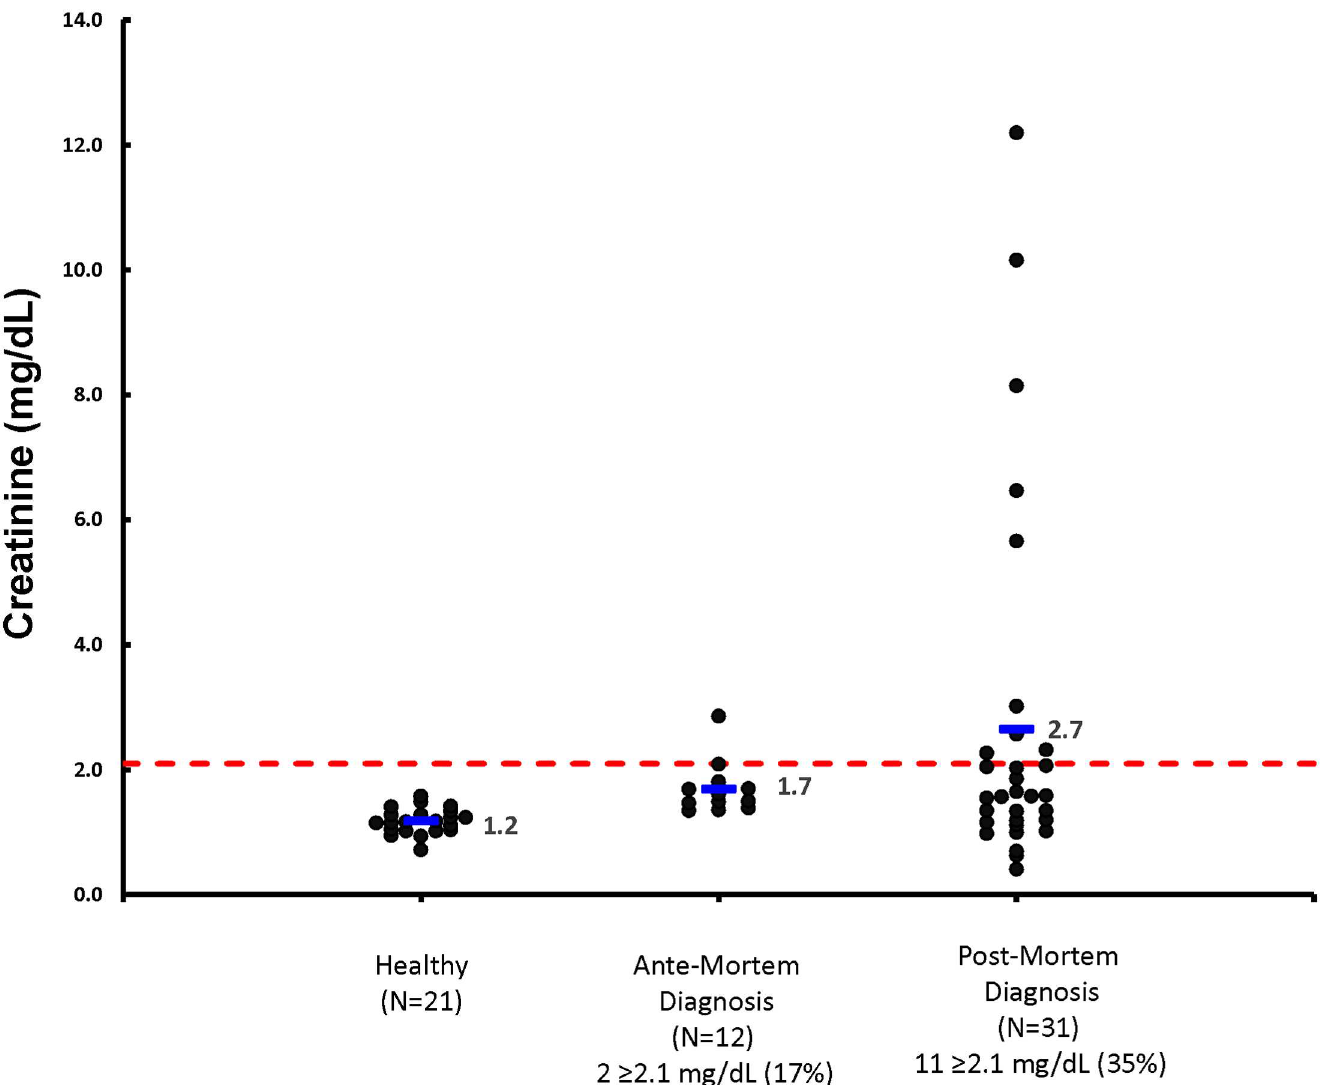
intervalfor serum Cr concentration (2.1 mg/dL). Individual cats in each group are representedby a black dot. The horizontal blue line represents the mean serum Cr concentration for the group. The number and percent of cats (cid:21) 2.1 mg/dL in each group are also indicated.